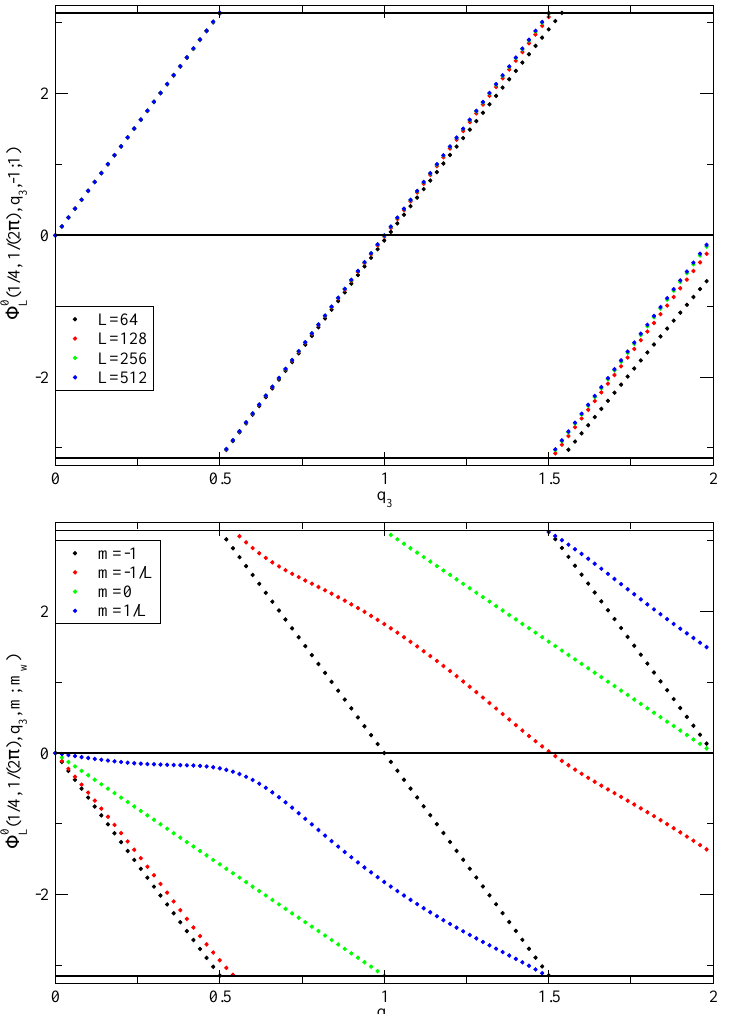
Figure 6. The figure is similar to Figure 1 showing the flow of the phase of the fermion determinant as a function of SU(2) gauge field magnitude q 3 . The top panel shows the result for infinitely massive fermion, m = 1 with regulator parameter m w = 1. The convergence of the results at different L − towards a continuum result is shown. The bottom panel shows the flow with q 3 at different fermion masses m